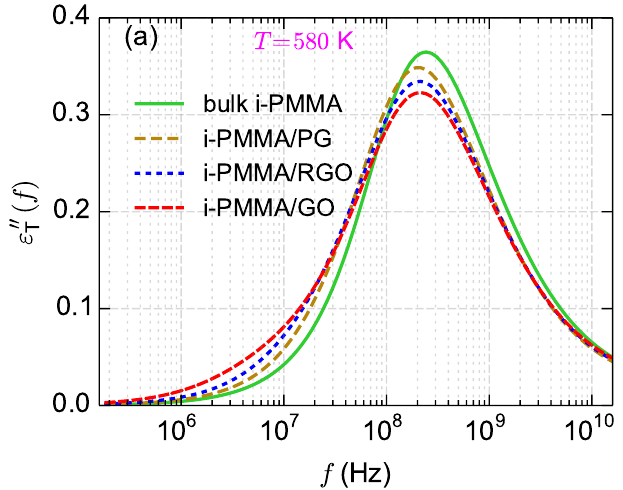
( f ) for the confined i-PMMA melts at T = 580 T